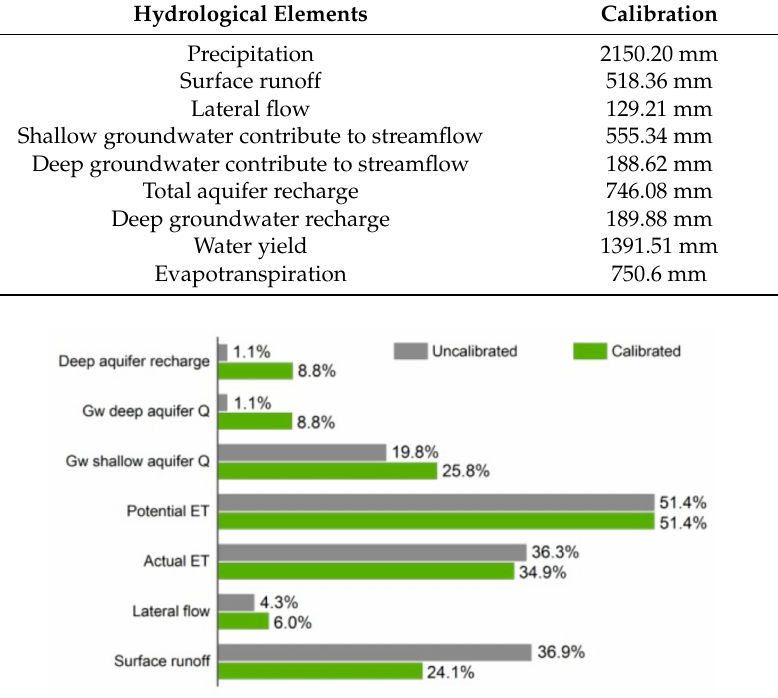
Figure 7. Average annual values of hydrological elements as a percentage of precipitation for pre- and post-calibration periods.